Question: Condense the content of this figure into a single sentence.
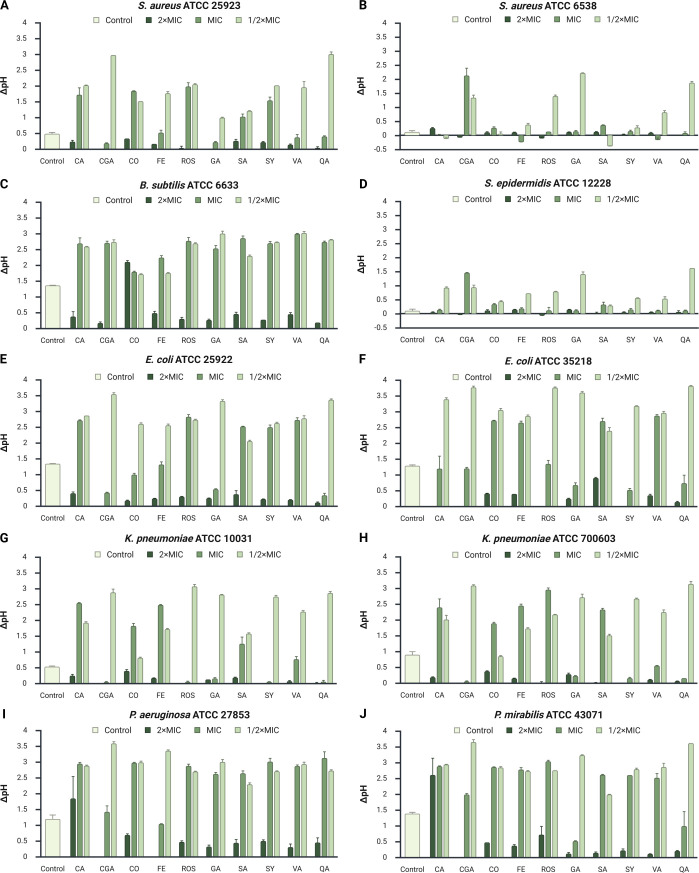
Answer: The change in pH (∆pH) during the 24-h MIC assay. ( A ) S. aureus ATCC 25923; ( B ) S. aureus ATCC 6538; ( C ) B. subtilis ATCC 6633; ( D ) S. epidermidis ATCC 12228; ( E ) E. coli ATCC 25922; ( F ) E. coli ATCC 35218; ( G ) K. pneumoniae ATCC 10031; ( H ) K. quasipneumoniae ATCC 700603; ( I ) P. aeruginosa ATCC 27853; ( J ) P. mirabilis ATCC 43071. MIC—minimum inhibitory concentration; CA—caffeic acid; CGA—chlorogenic acid; CO —p -coumaric acid; FE—ferulic acid; ROS—rosmarinic acid; GA—gallic acid; SA—salicylic acid; SY—syringic acid; VA—vanillic acid; QA—quinic acid. Created in BioRender.com. Bārzdiņa, A. (2026) https://BioRender.com/v38i9ha .